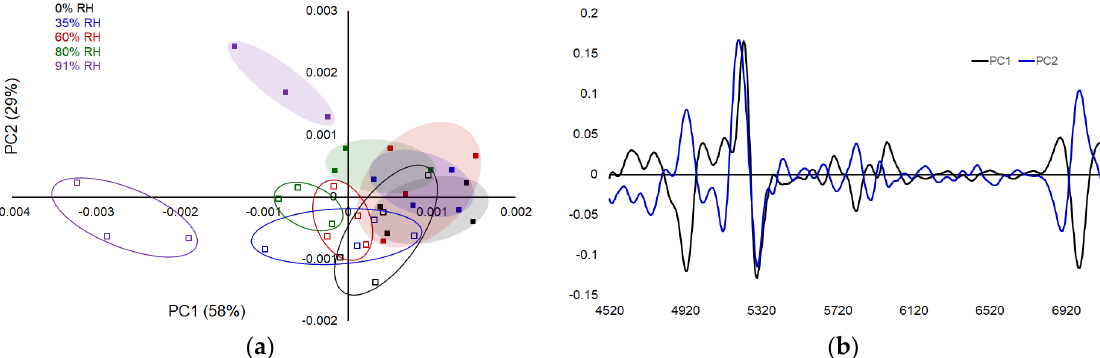
Figure 2. PC scores ( a ) in the 4520–6950 cm − 1 region for non-extracted and water-extracted spruce wood specimens (full symbols—non-extracted specimens; open symbols—water-extracted specimens; colours represent the different levels of RH during heating) and loadings ( b ) in the same region.